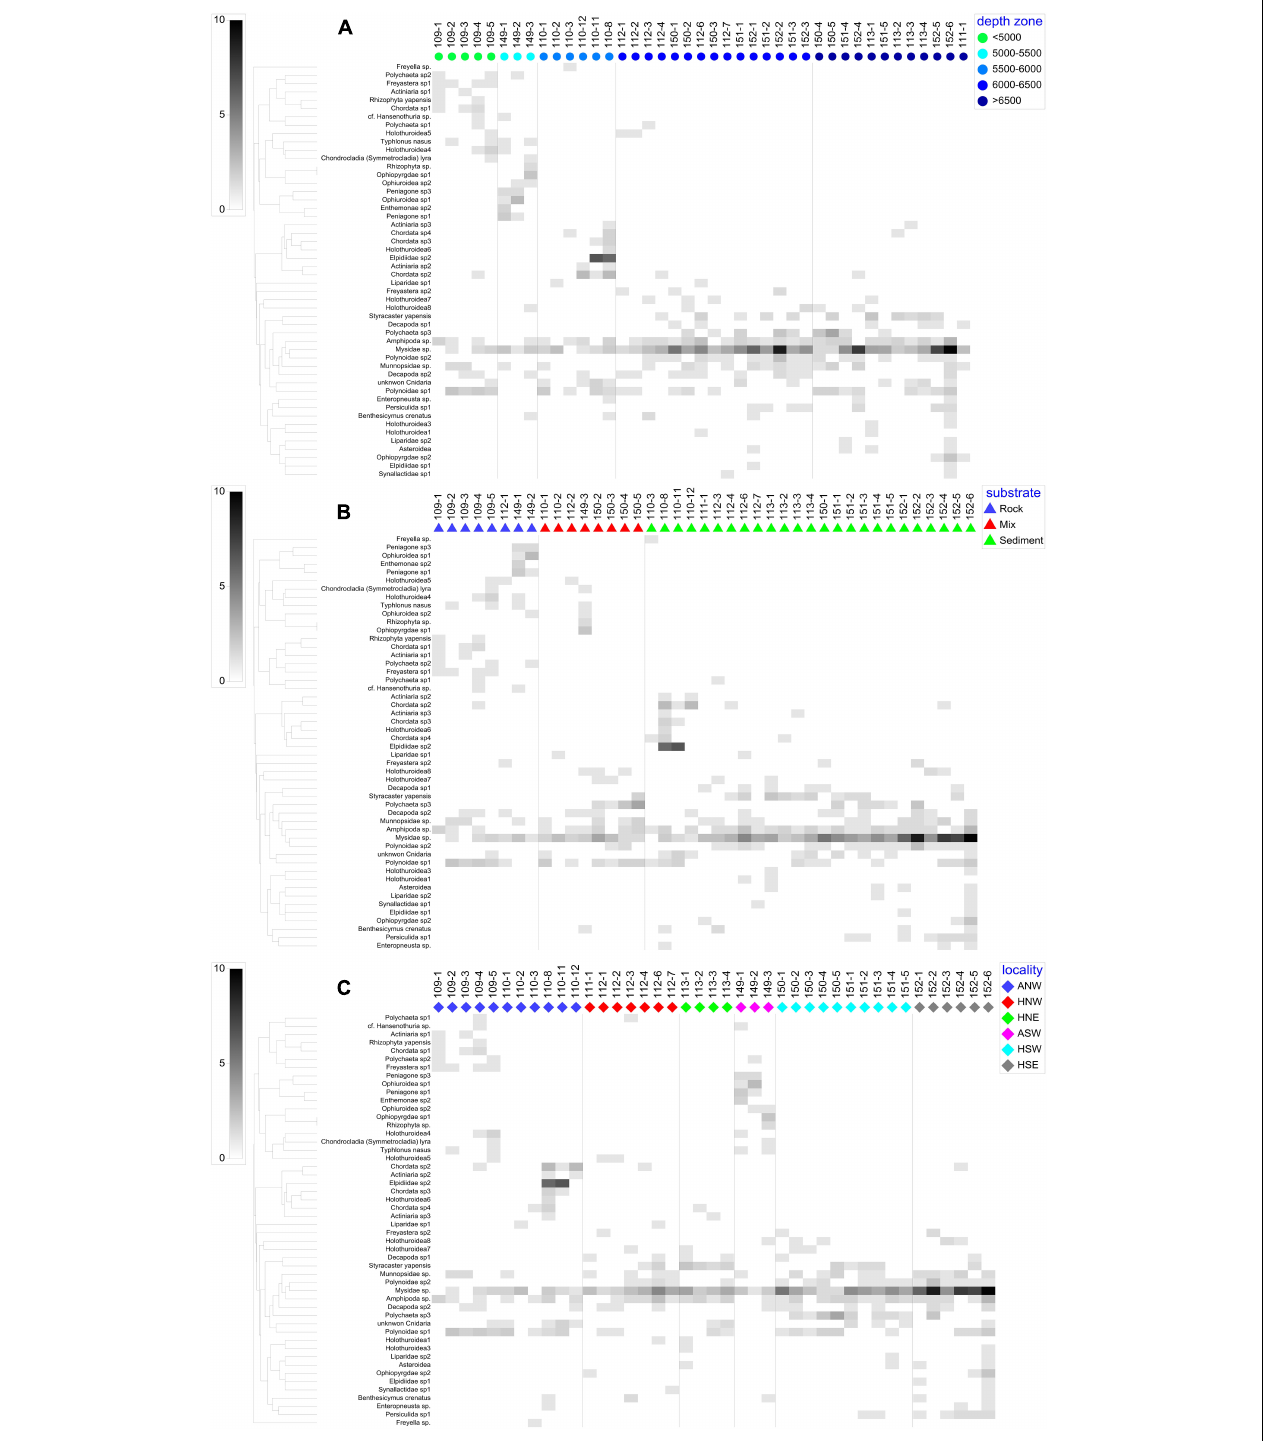
FIGURE 7 | Shade plots showing the variation of megafaunal communities in the Yap Trench with (A) depth zone, (B) substrate type, and (C)